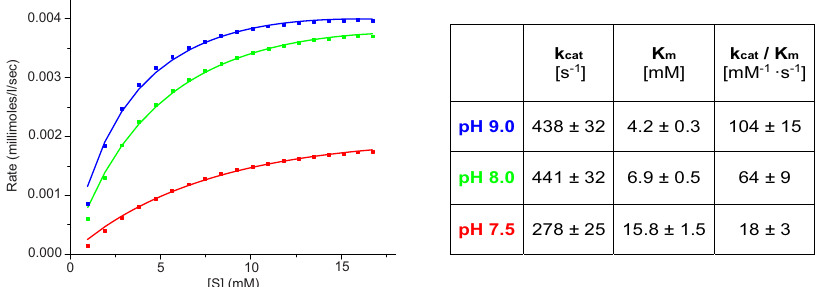
Fig. 4 Michaelis – Menten analysis of ITC titration data. Left panel: Michaelis – Menten curves from single heat-rate ITC titrations at pH 7.5 (red), 8.0 (green) and 9.0 (blue). The reaction rates obtained from steady-state heat- fl ow levels after each injection were plotted against L-Asn concentration and fi tted to the Michaelis-Menten equation. Right panel: Summary of the kinetic parameters at each pH condition. The averaged values and their standard deviations were estimated from three separate experiments. Source data are provided as a Source Data fi le.